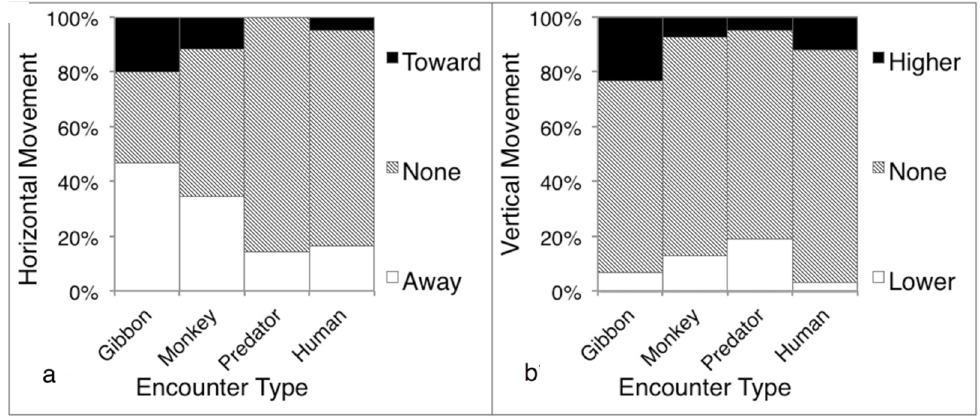
Figure 4. ( a ) Horizontal movement and ( b ) Vertical movement in the canopy by encounter type (gibbon, human, monkey, predator). Labels correspond to colors on the key on the right. ** p < 0.01. For all encounter types, gibbons generally did not change their vertical position in the canopy, but they moved lower in the canopy less than expected by χ 2 probabilities assuming that encounter type did not affect gibbon movement when encountering humans (N = 12, χ 2 = 4.52) and more than expected when encountering monkeys (N = 12, χ 2 = 8.95) and avian predators (N = 4, χ 2 = 6.83). Upon encountering humans, gibbons most often did not change their vertical position (N = 334). They moved higher in the canopy (N = 48) more often than they moved lower in the canopy (N = 12), but this difference was not significant (Figure 4; N = 538 χ 2 = 27.176, df = 6, p =